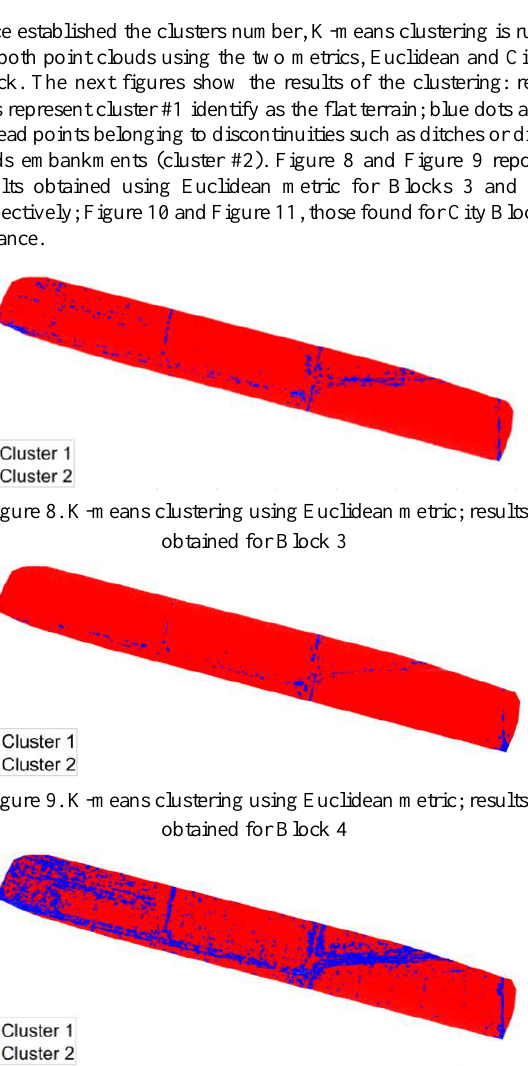
Figure 10. K-means clustering using City Block metric; results obtained for Block 3